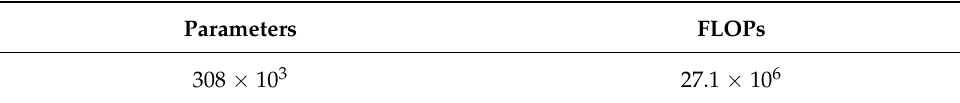
Table 2. Computation cost of our proposed